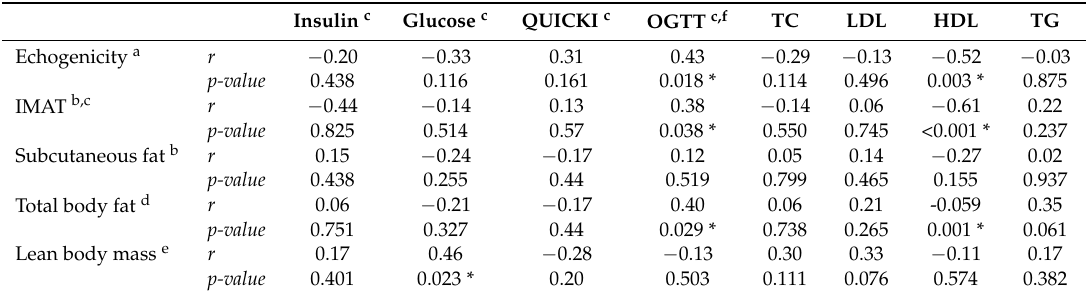
Table 3. Associations among surrogate measures of muscle quality, body composition estimates, and metabolic parameters. Insulin c Glucose c QUICKI